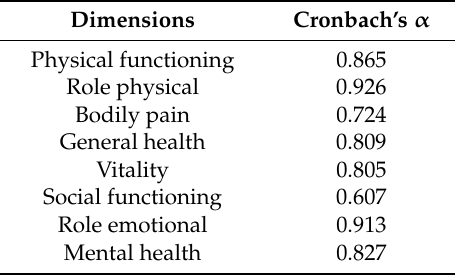
Table 3. The Cronbach’s α for the eight domains of the SF-36v2 questionnaire. Dimensions